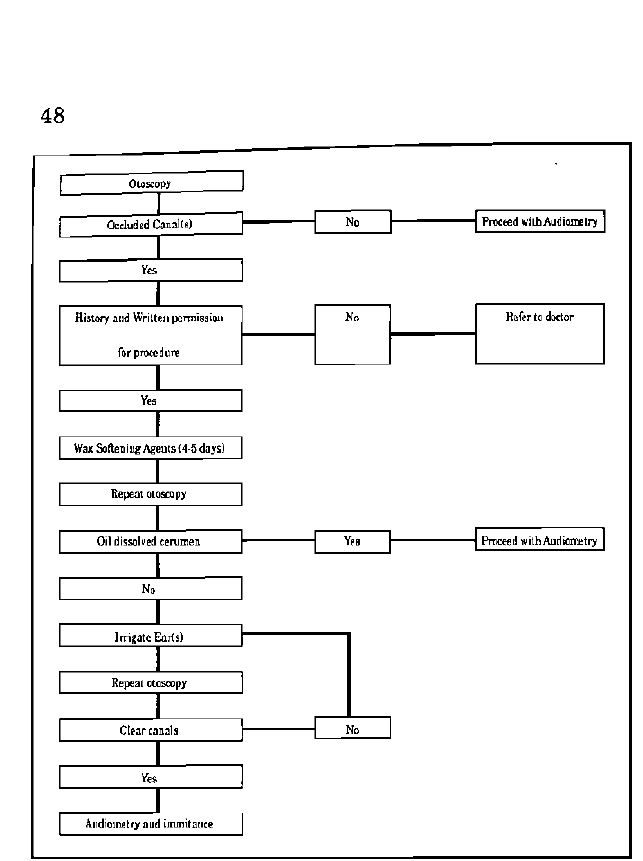
FIGURE 2: Flow chart of procedures for Cerumen Management Preschool